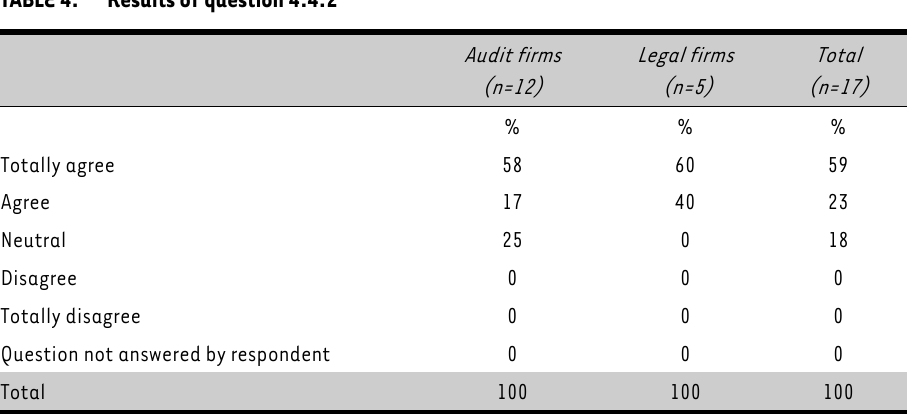
TABLE 4: Results of question